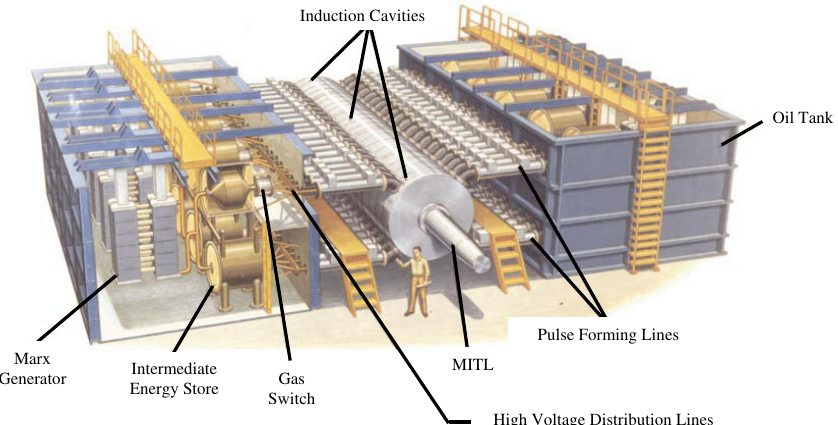
FIG. 32. (Color) Hermes-III showing details of Marxes and intermediate